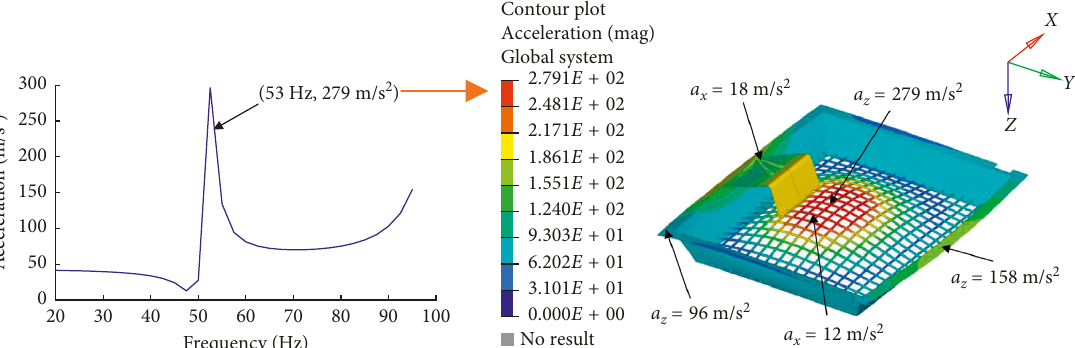
Figure 3: Dynamic frequency response: (a) acceleration variation with frequency; (b) acceleration distribution of the screen under ex- citation of 53 Hz.